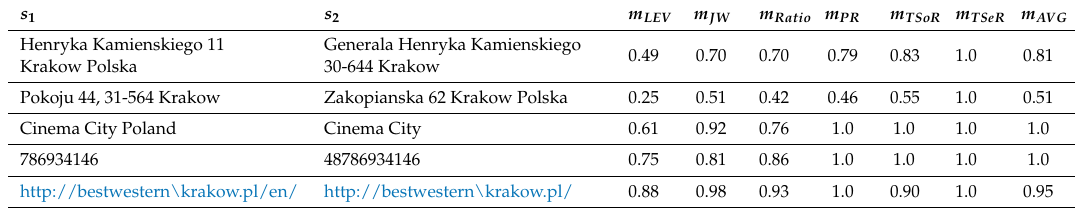
Table 1. Comparison of the values of the analyzed metrics for sample